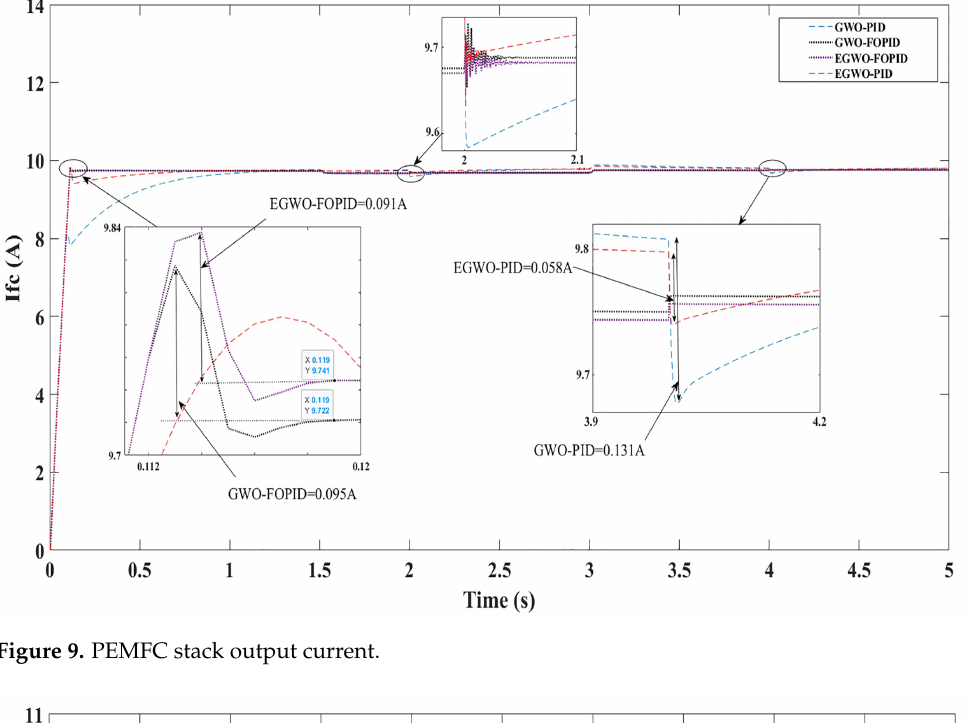
Figure 9. PEMFC stack output current.